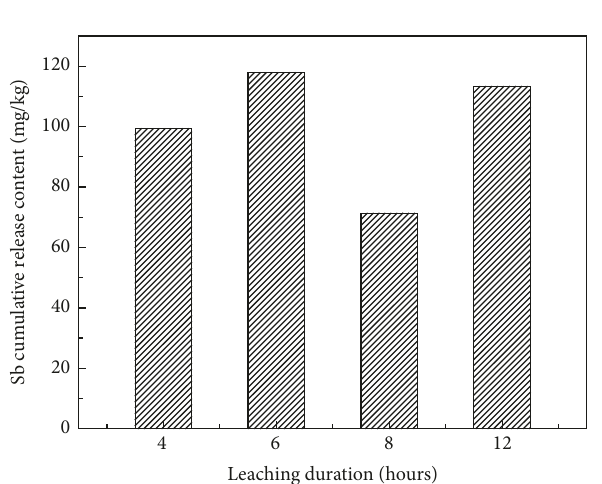
Figure 8: Cumulative amount under different rainfall duration.